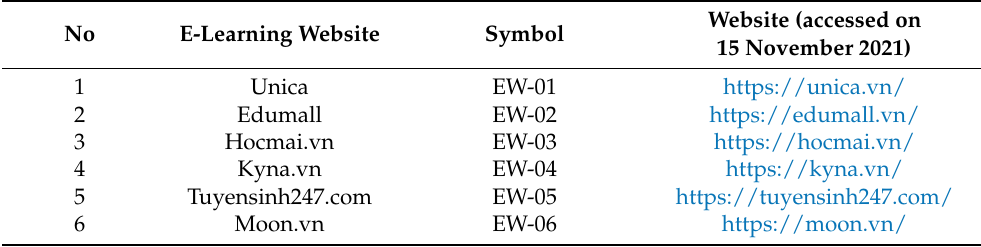
Table 3. The list of e-learning websites used in this study.